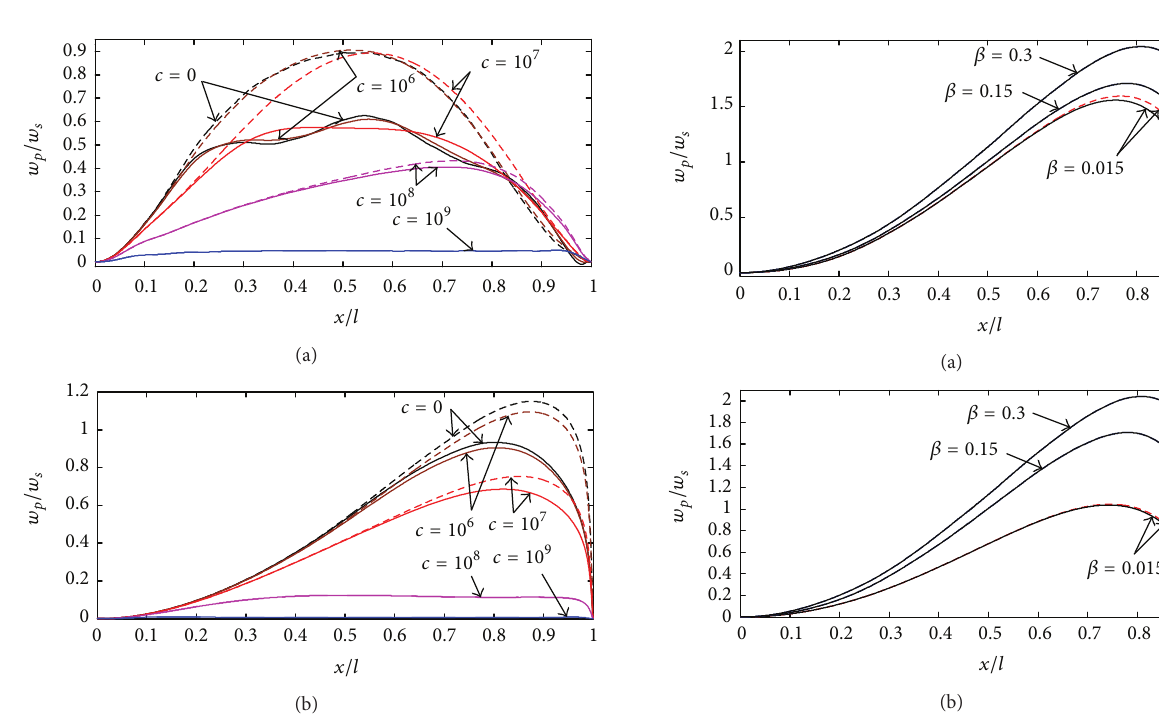
Figure 8: Variation of dimensionless instantaneous dynamic lateral deflection, 𝑤 𝑝 /𝑤 𝑠 , versus normalized instantaneous position of moving mass, 𝑥/𝑙 , of the Timoshenko beam with different 𝑐 values traveled at two different speeds with 𝑚 = 3𝜌𝐴𝑙 kg, 𝑘 1 = 10 10 N/m 2 , and 𝛽 = 0.3 . (a) 𝛼 = 0.11 , (b) 𝛼 = 0.5 ; (- - - - -) M-1 model and (—) M-2 or M-3 model with 𝑘 3 = 10 22 N/m 4 .